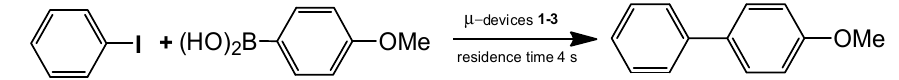
membrane surface (c). (Reprinted from [62]).